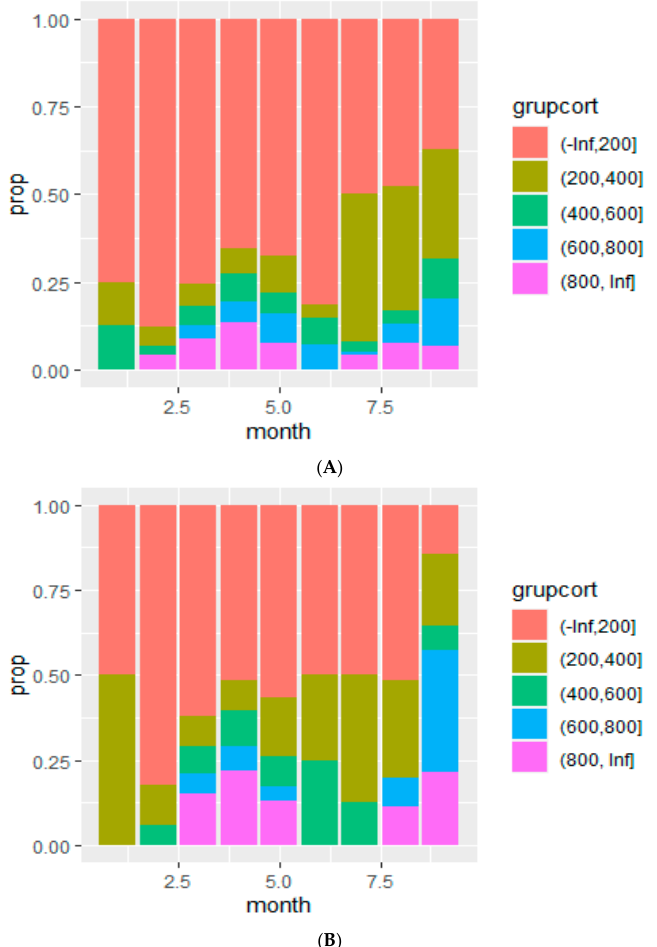
Figure 3. ( A ) Evolution of the dose of accumulated prednisone equivalents administered to patients admitted with COVID-19; ( B ) evolution of the dose of accumulated prednisone equivalent administered dose to patients admitted with severe COVID-19 (modified WHO criteria).